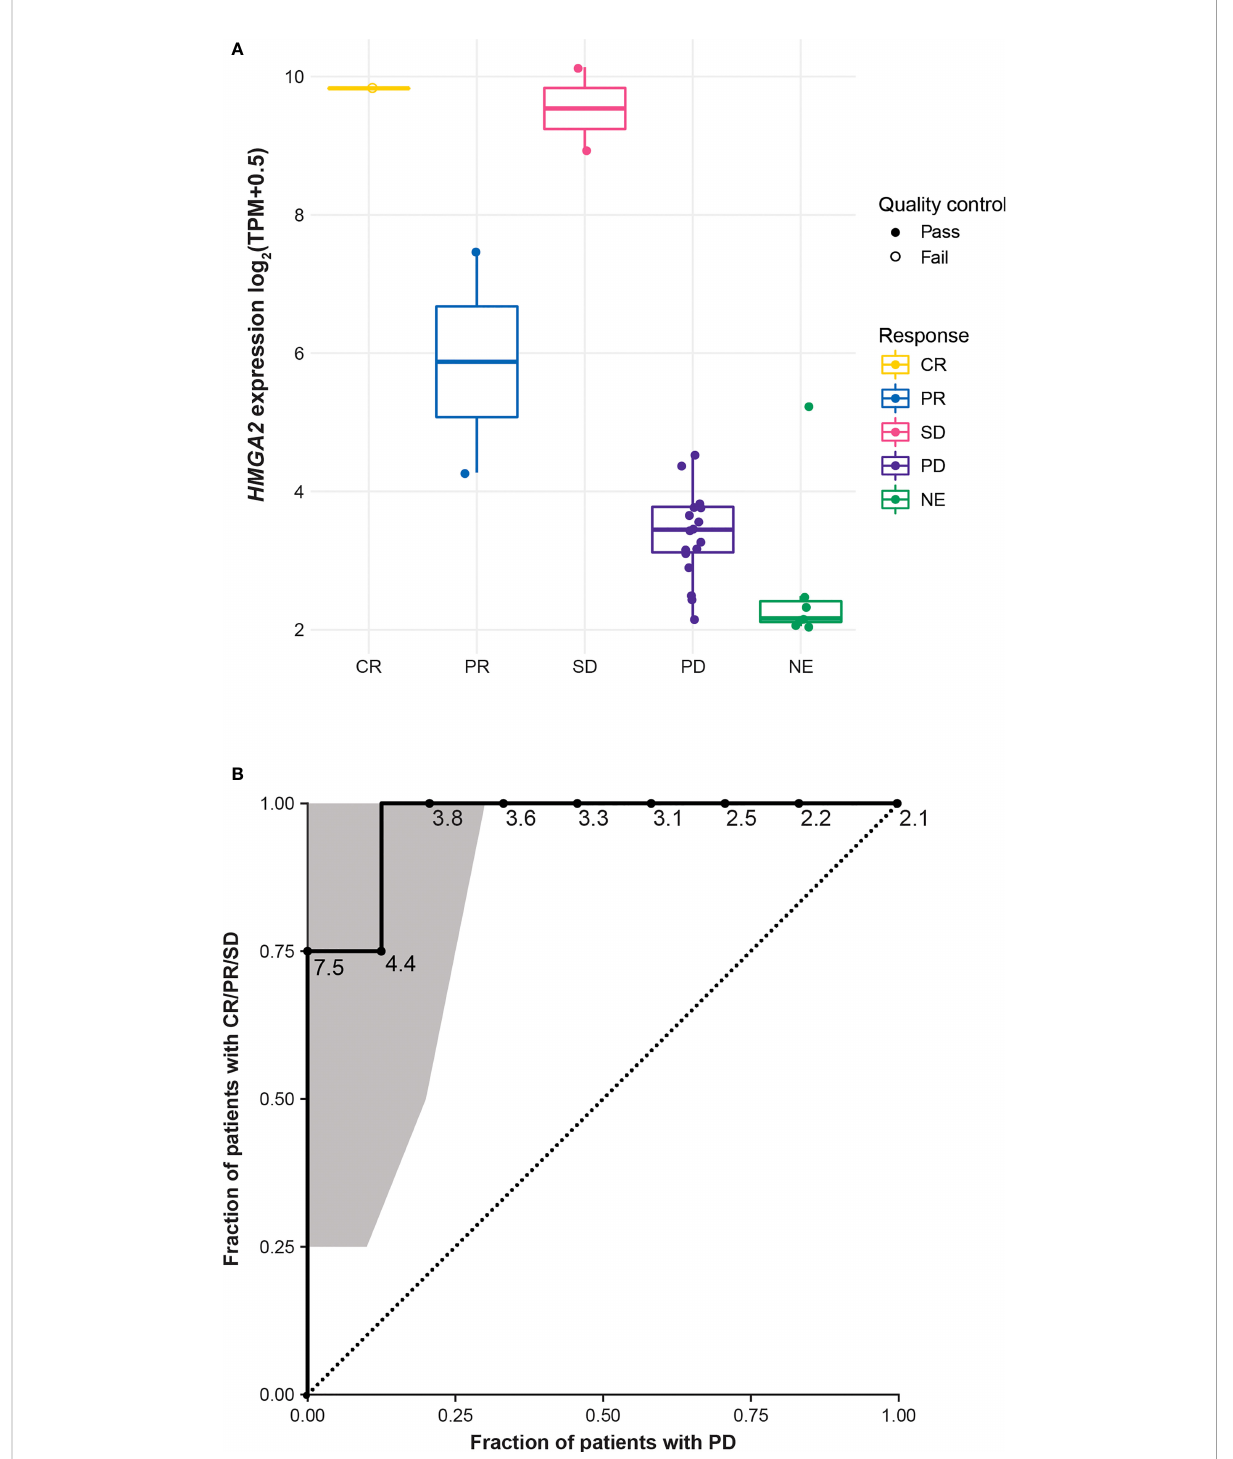
FIGURE 3 HMGA2 expression by IRC-assessed BOR* (A) and ROC curve with the 95% CI computed by R package pROC using default parameters* † (B) . *Three samples from patients with a BOR of PD are not included in this fi gure due to lack of sample or sequencing failure. † One sample from a patient with a BOR of CR was excluded from the formal biomarker assessment due to failing quality control. BOR, best overall response; CR, complete response; HMGA2, high mobility group AT-hook 2; IRC, independent review committee; NE, not evaluable; PD, progressive disease; PR, partial response; ROC, receiver operating characteristic; SD, stable disease; TPM, transcripts per